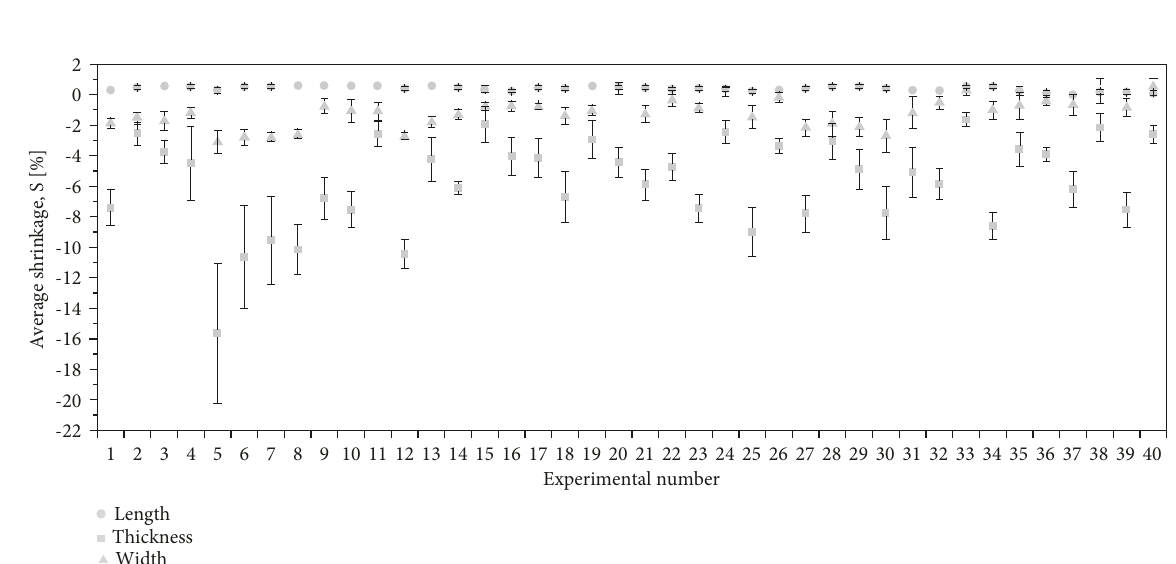
Figure 4: Average shrinkage of flexion samples.